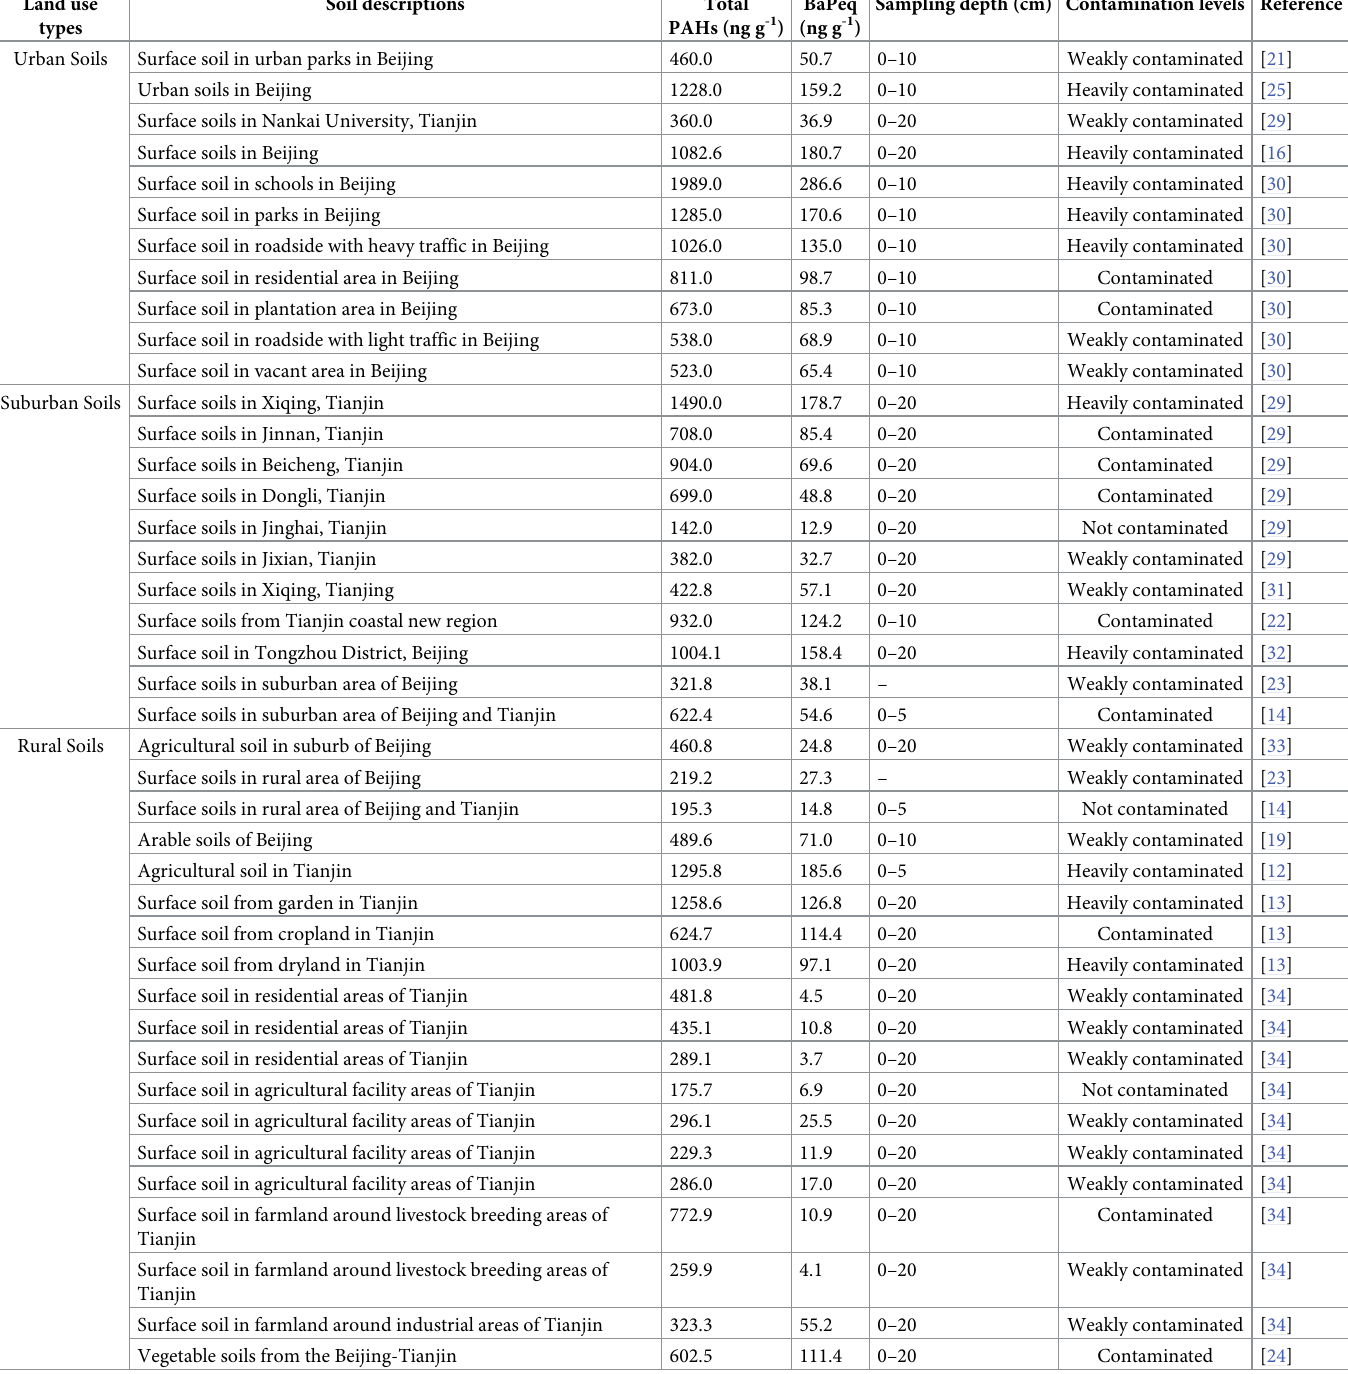
Table 1. Summary of PAHs concentrations in different land use types in Beijing and Tianjin. Land use